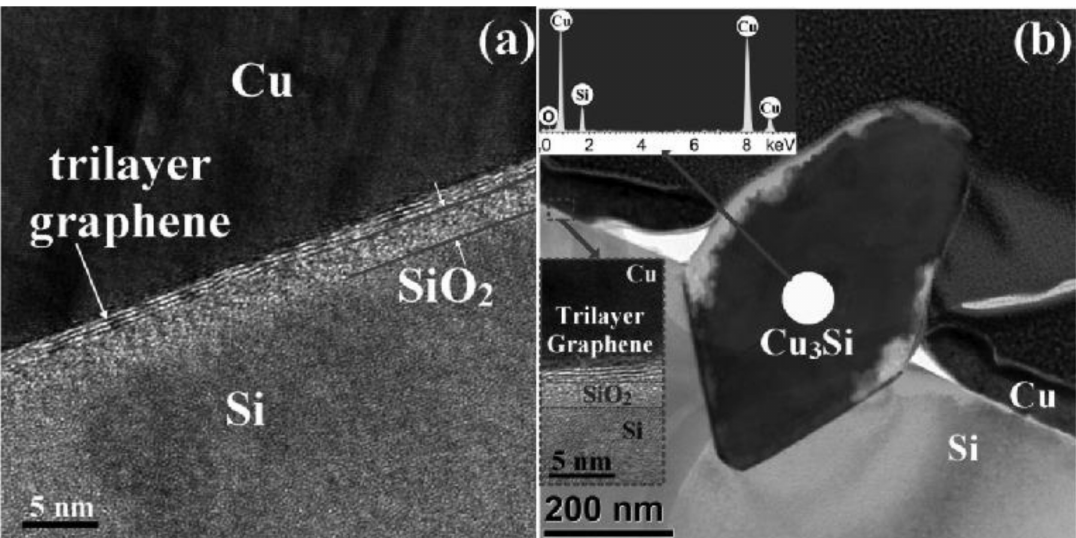
Figure 6. Cross-sectional TEM images of a tri-layer graphene film ( a ) before and ( b ) after 30 min of annealing at 700 ◦ C. A distinct boundary between Cu and graphene can be seen even after ( b ) 5 min of annealing at 800 ◦ C. Inset at top left in panel ( b ) indicates the formation of copper silicide and a cross-sectional image of the undegraded graphene layer is displayed at the bottom left. Reproduced from Nguyen et al. [140]. Copyright 2014 AIP Publishing